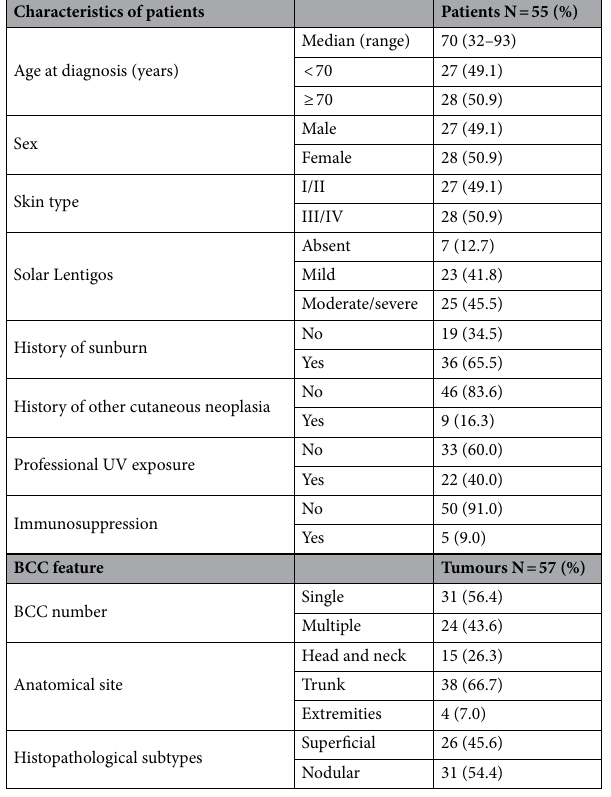
Table 1. Demographic and Clinical-pathological features of patients and